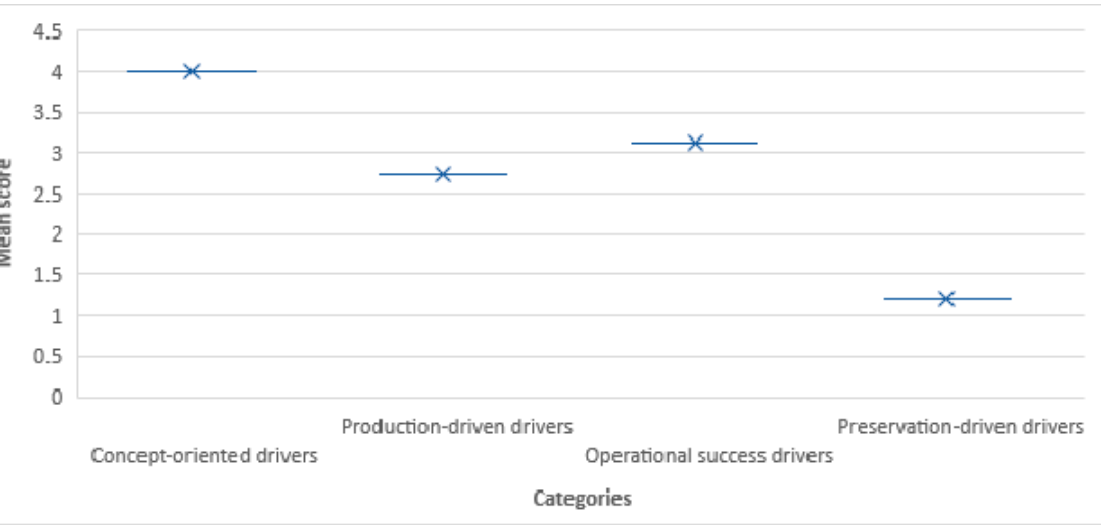
Figure 4. Graphical representation of the mean scores of the categories.